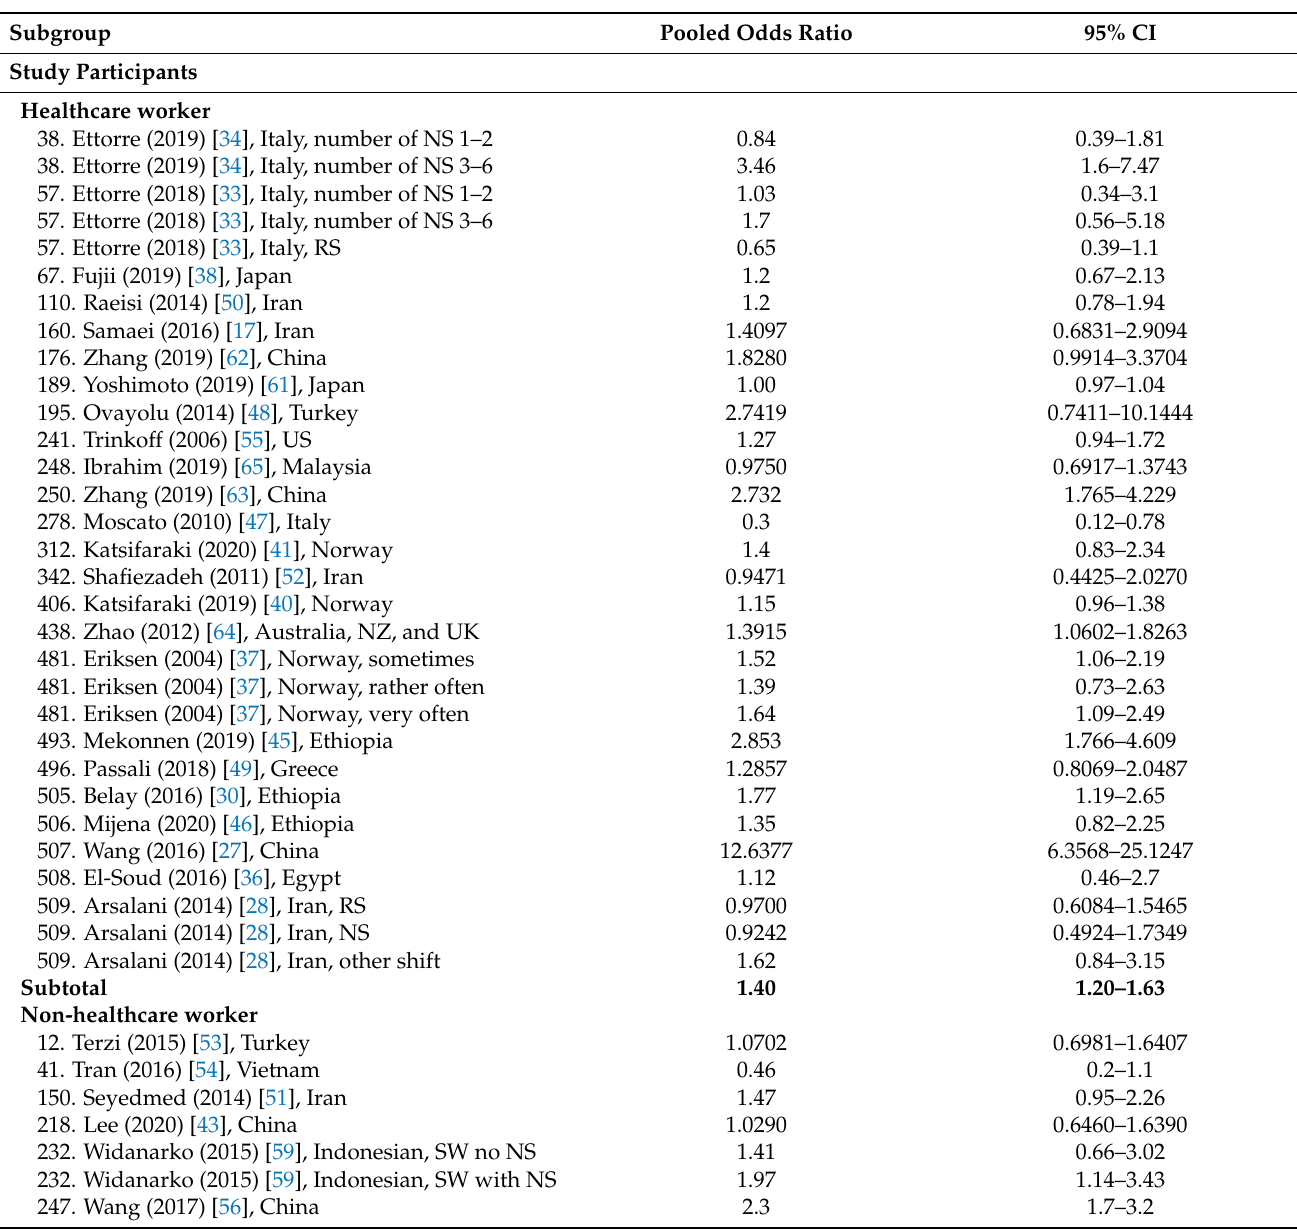
Table 3. Subgroup analysis of odds ratio for healthcare workers (HCWs) and non-HCWs exposed to shift